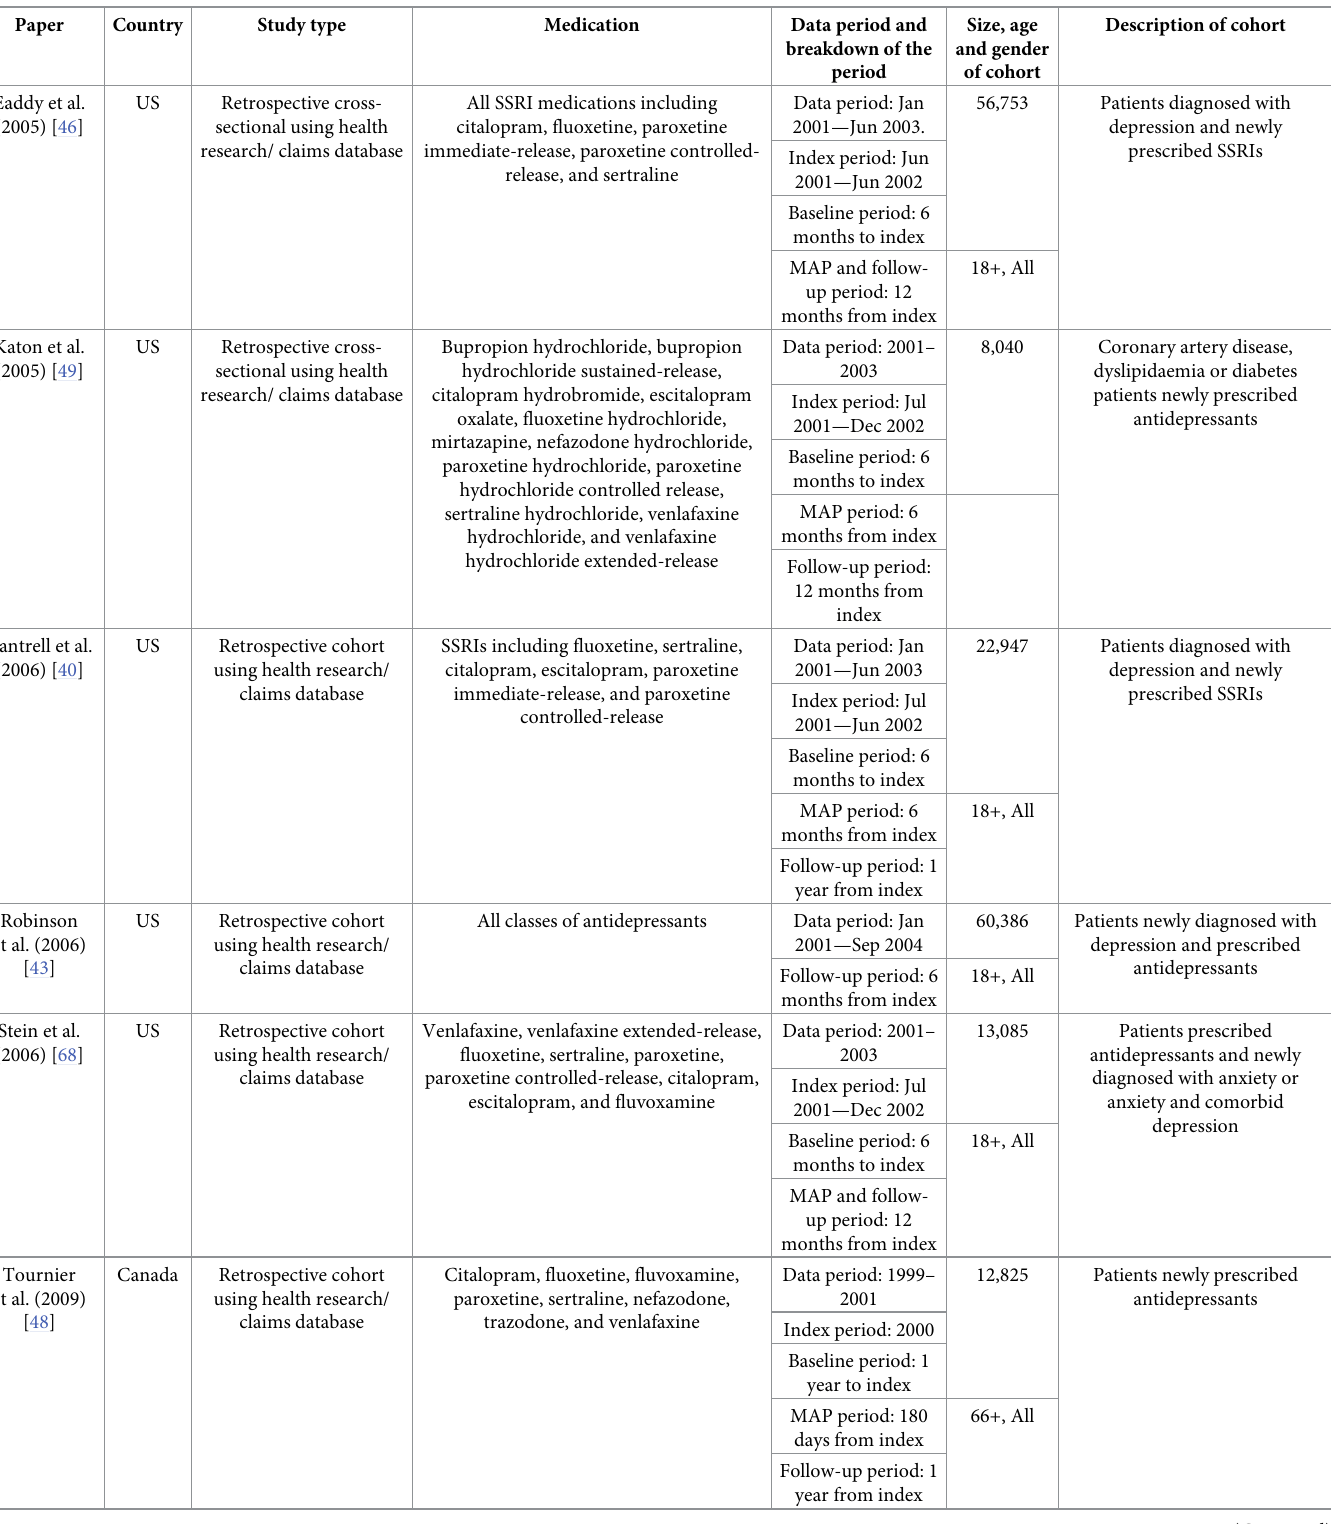
Table 3. Characteristics of reviewed studies on antidepressants.